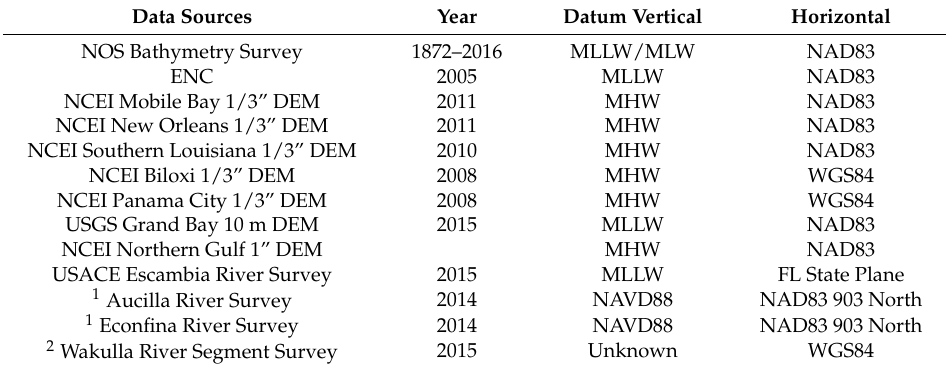
Table 1. Bathymetry data source